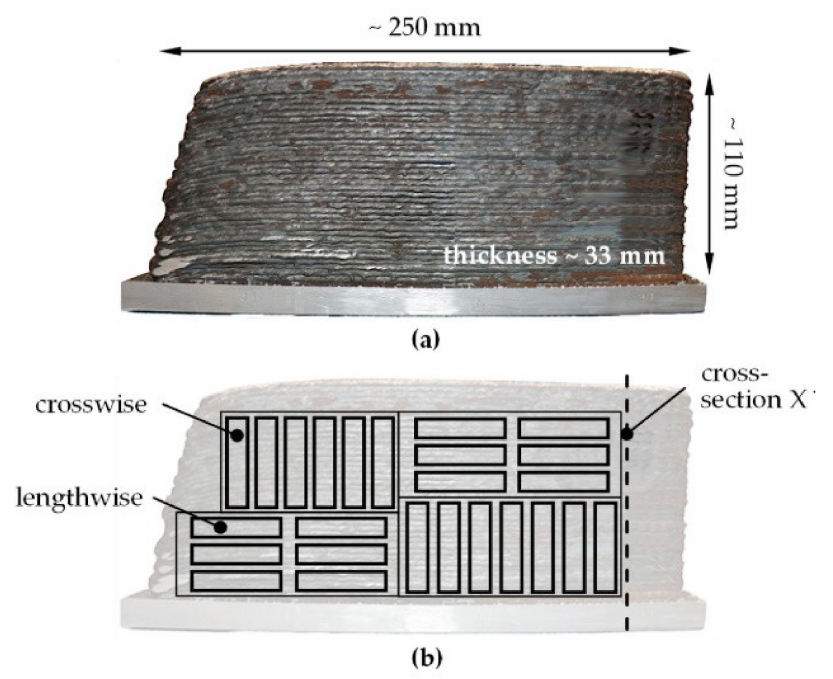
Figure 20. Wire arc additive manufacturing (WAAM) material: ( a ) semi-finished block products, ( b ) sampling plan for tensile specimens with directional designation related to the weld layers [189].